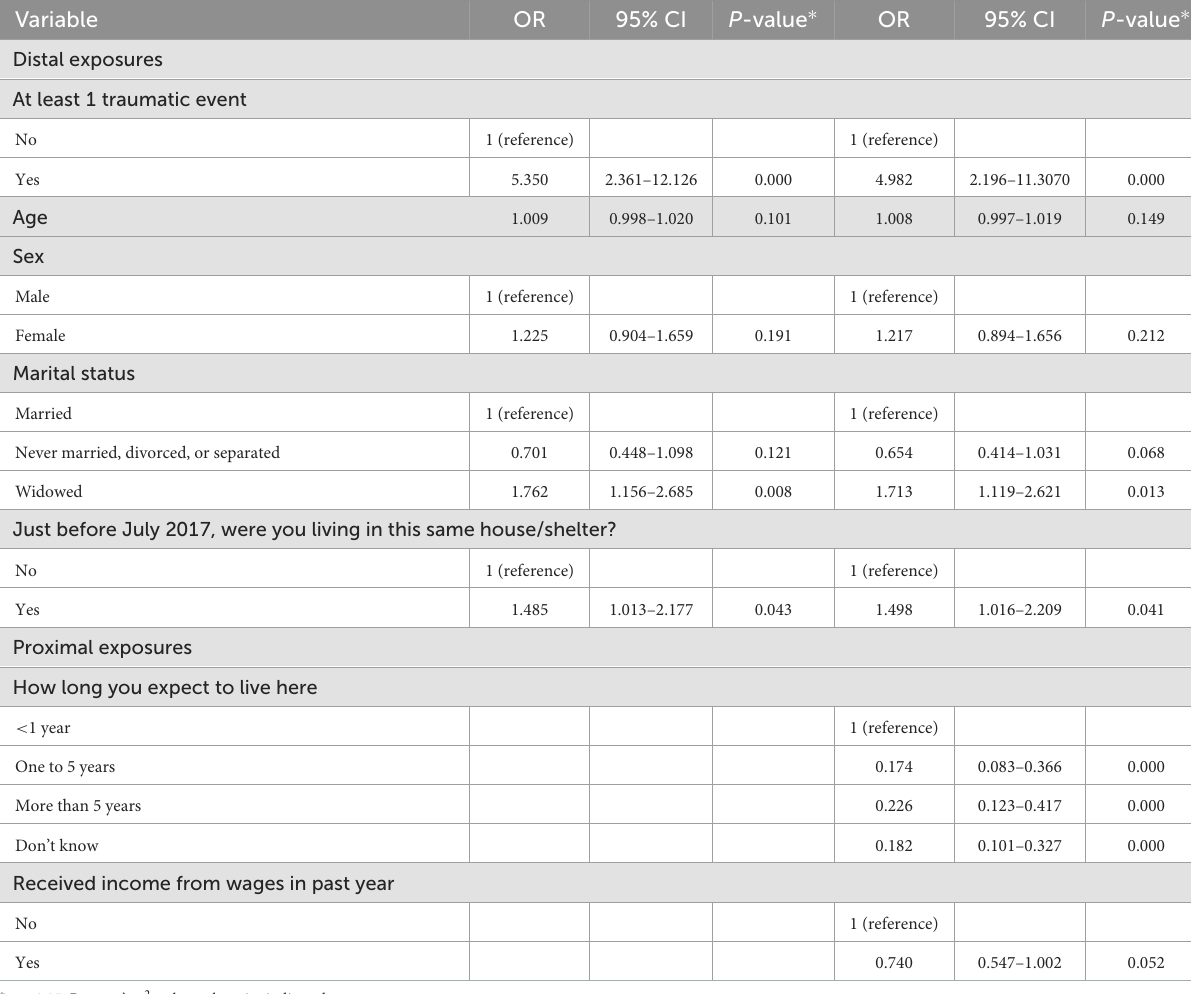
TABLE 4 Multivariable logistic regression model for PTSD among Rohingya refugees in Cox’s Bazar, Bangladesh, stratified by gender ( n = 4,349).